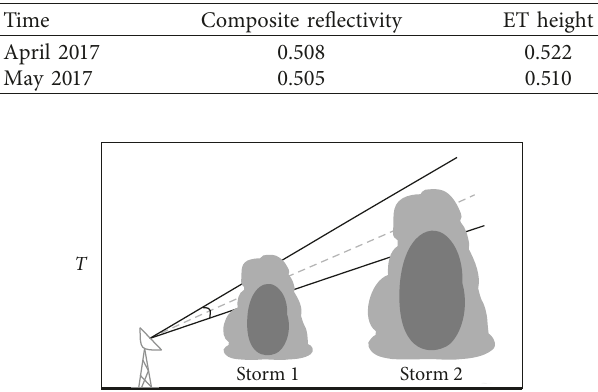
Table 1: The correlation coefficients between reflectivity/ET height and observational rainfall.